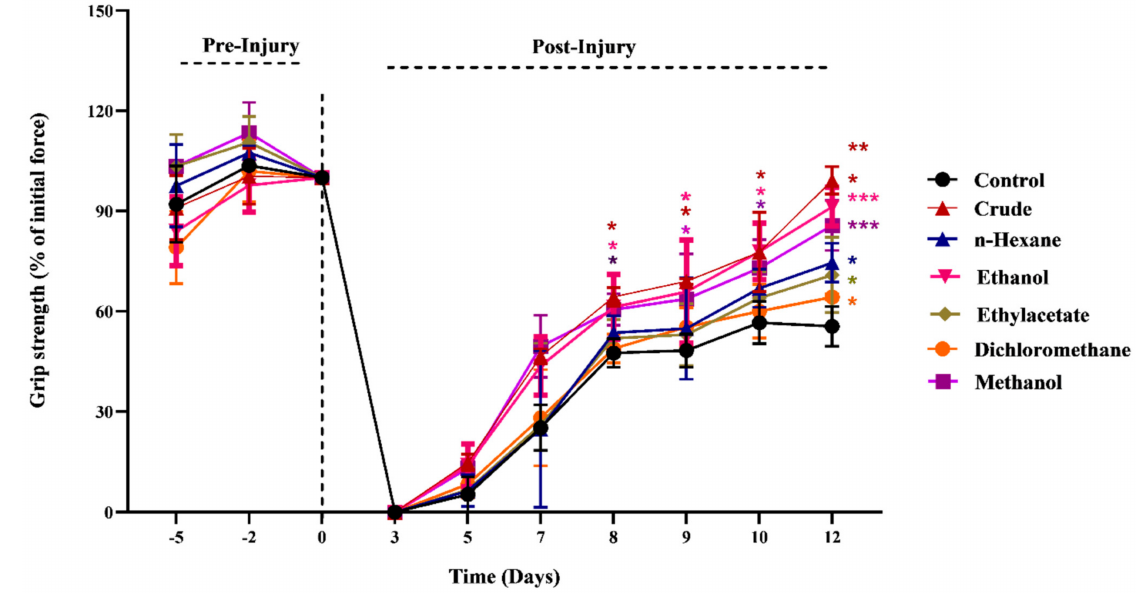
Figure 2. Influence of M. oleifera on muscle grip strength following sciatic nerve lesion. *, **, *** show the significance of results